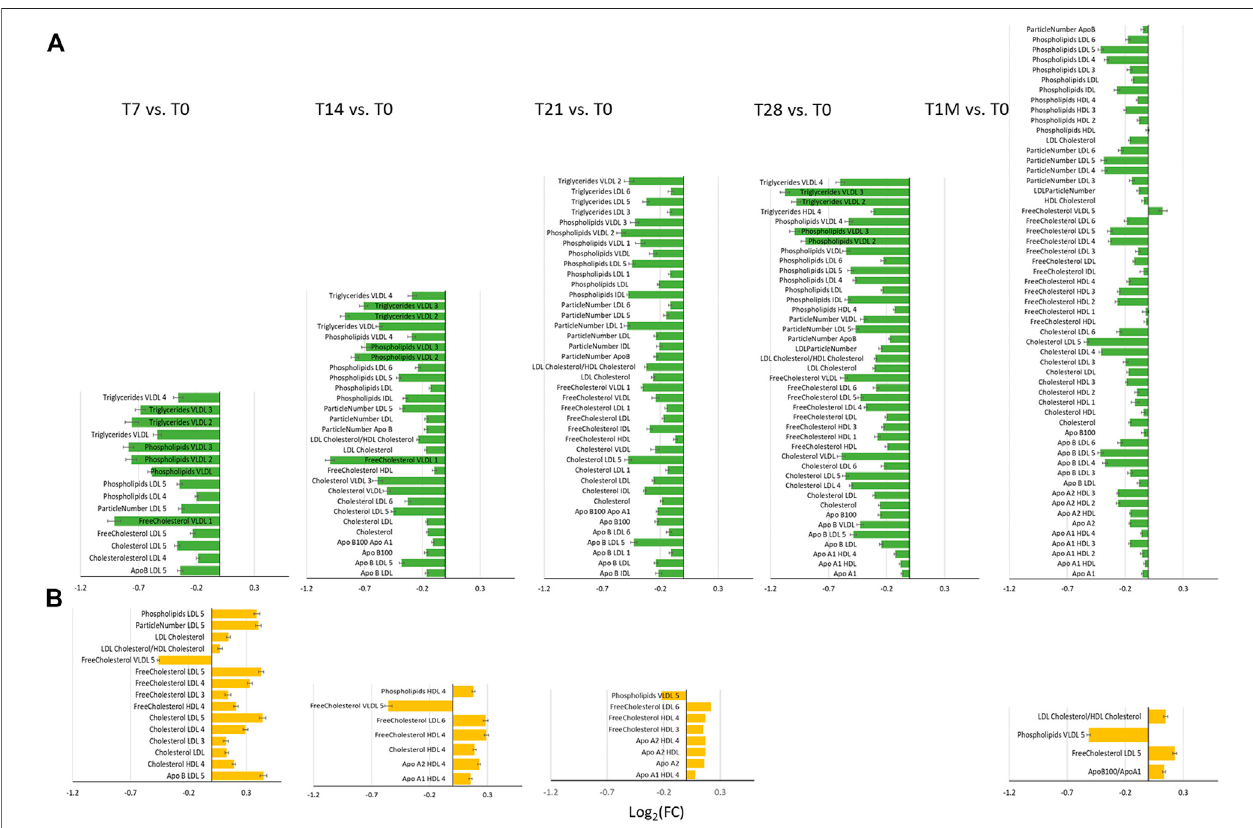
FIGURE3| BarplotsofLog 2 (FC)oflipoproteinrelatedparameterssigni fi cantlydifferentforthecomparisonatT7,T14,T21,T28andT1MwithrespecttoT0,in (A) COVID-19-naïve (green plots) and (B) COVID-19-recovered (orange plots) groups. Features with Log 2 (FC) positive/negative values have higher/lower concentration in T7, T14, T21, T28 and T1M samples with respect to